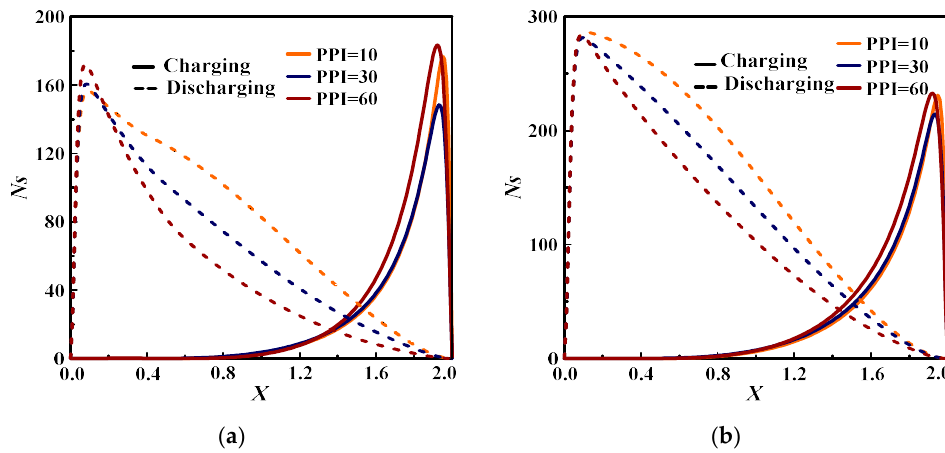
Figure 10. Pore density effect on the dimensionless entropy generation rate during charging and discharging processes at 0.9 : ( a ) Re=200; ( b ) Re=400.